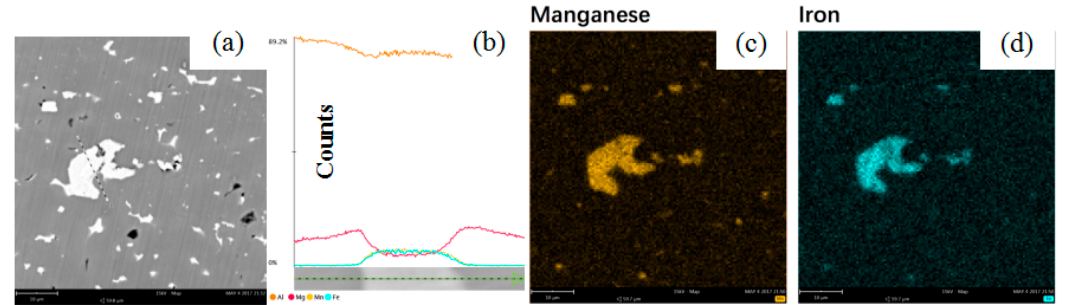
Figure 8. ( a ) A typical image, ( b ) an EDS line scan of Al-Mn-Fe phase in the PMZ, and EDS mapping of ( c ) Mn and ( d ) Fe.